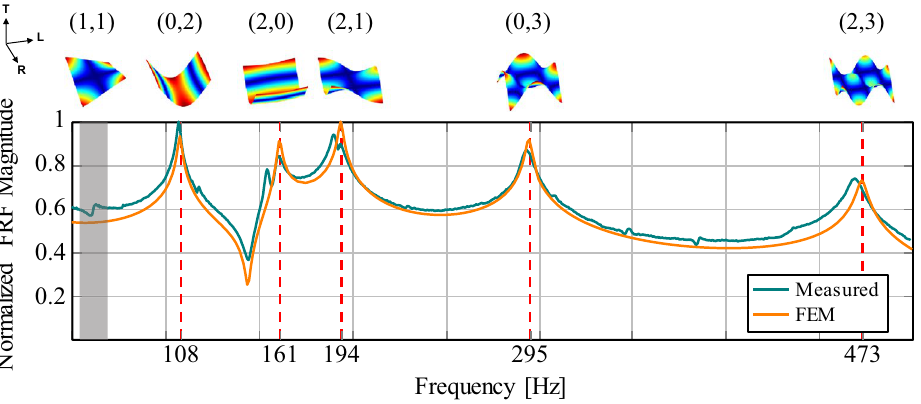
Figure 2. Comparison between FRF measured (in cyan) and FEM simulation (in orange) obtained with the estimated elastic constants. In the example, plate 4 is considered. The resulting magnitudes are normalized between 0 and 1. Measurements from white specimens were fitted as in 23 and using Rayleigh damping with − 1 − 6 constants α = 10 [ s ] and β = 2 × 10 [s], according to 24 . The eigenfrequencies obtained numerically and corresponding to resonances in the measure are highlighted with dashed red lines. In the measurement points chosen, modes with a nodal line along the longitudinal axis of symmetry are attenuated, e.g. (1,1) (colored in gray), making the peaks of interest easier to identify. The mode shape associated to each resonance is depicted above the plot, denoted with a notation based on nodal lines and widely used in the literature 25 .